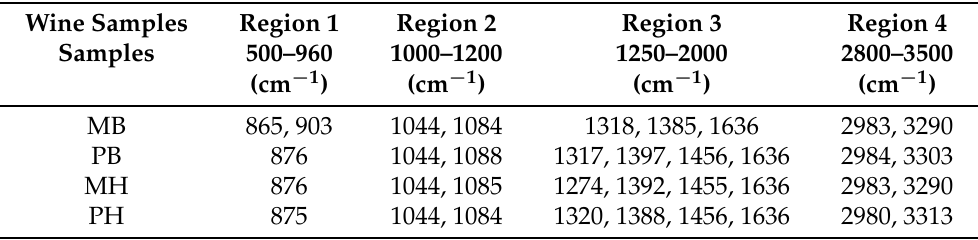
Table 4. Wavenumber regions measured in the studied wine samples, similar to those reported by